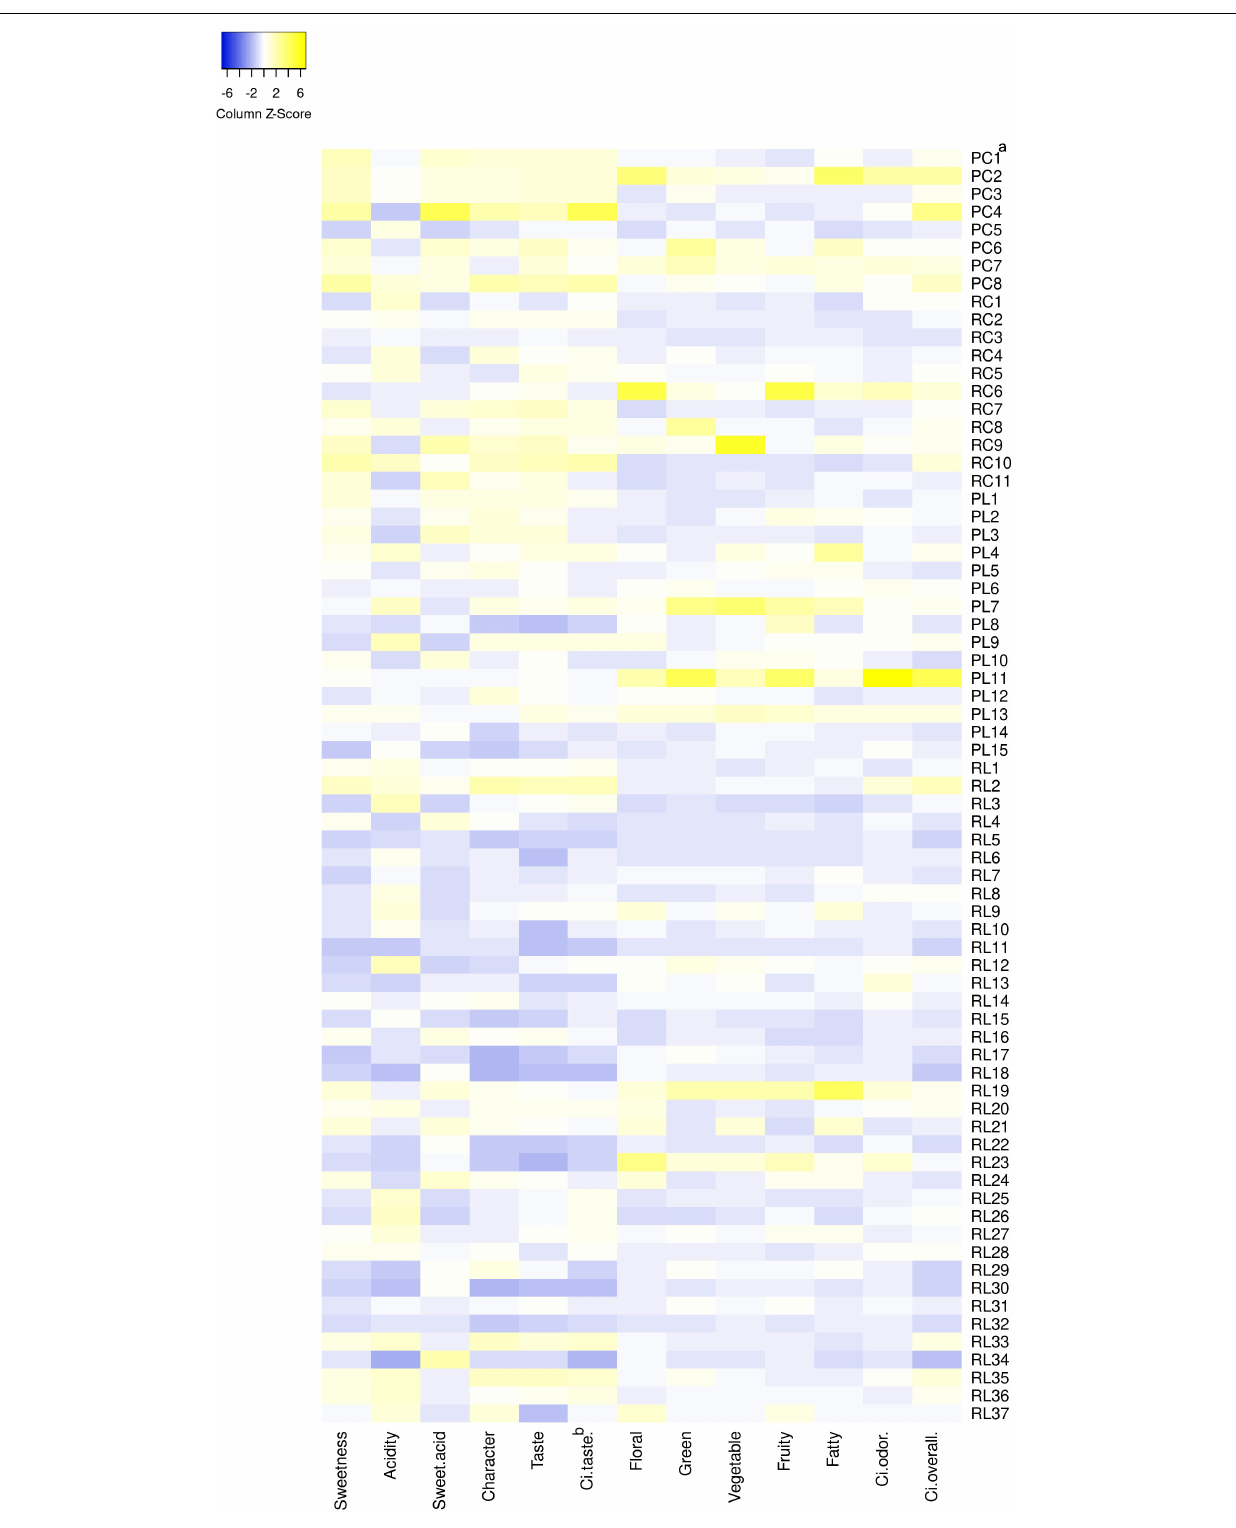
Frontiers in Plant Science |